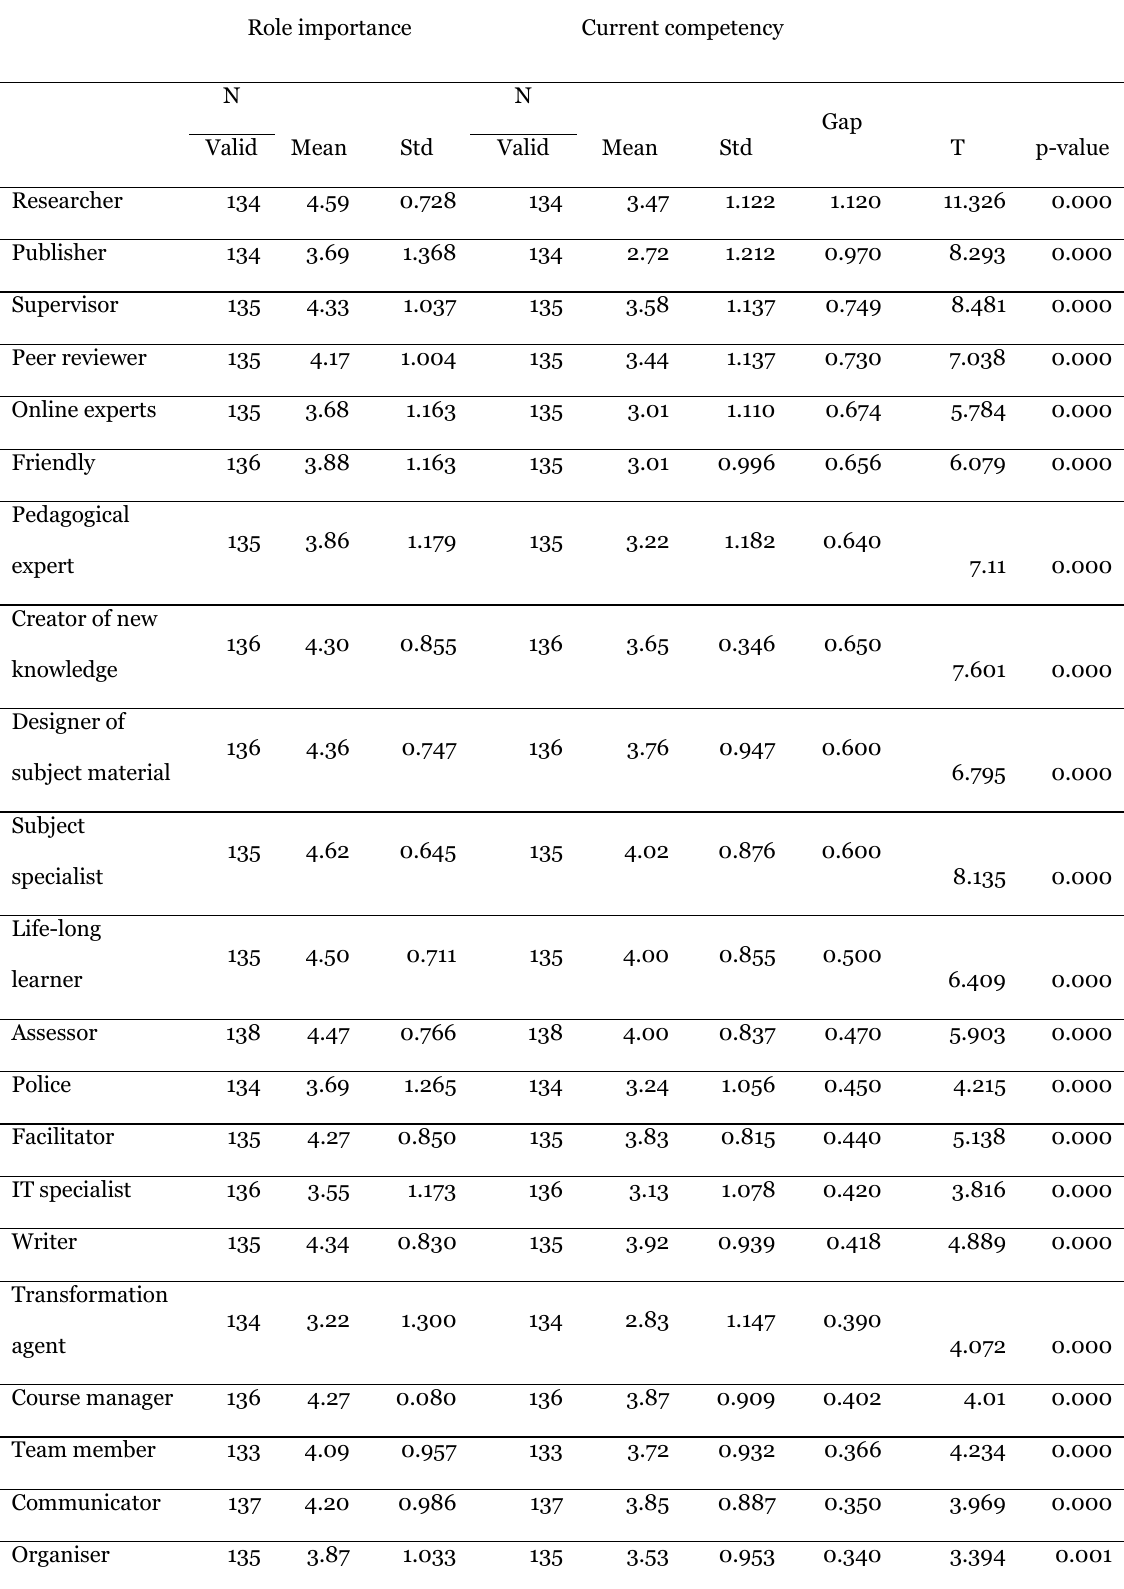
Table 2 Paired Samples T-Test to Show Significance of Perceived Importance Competence Gaps Role